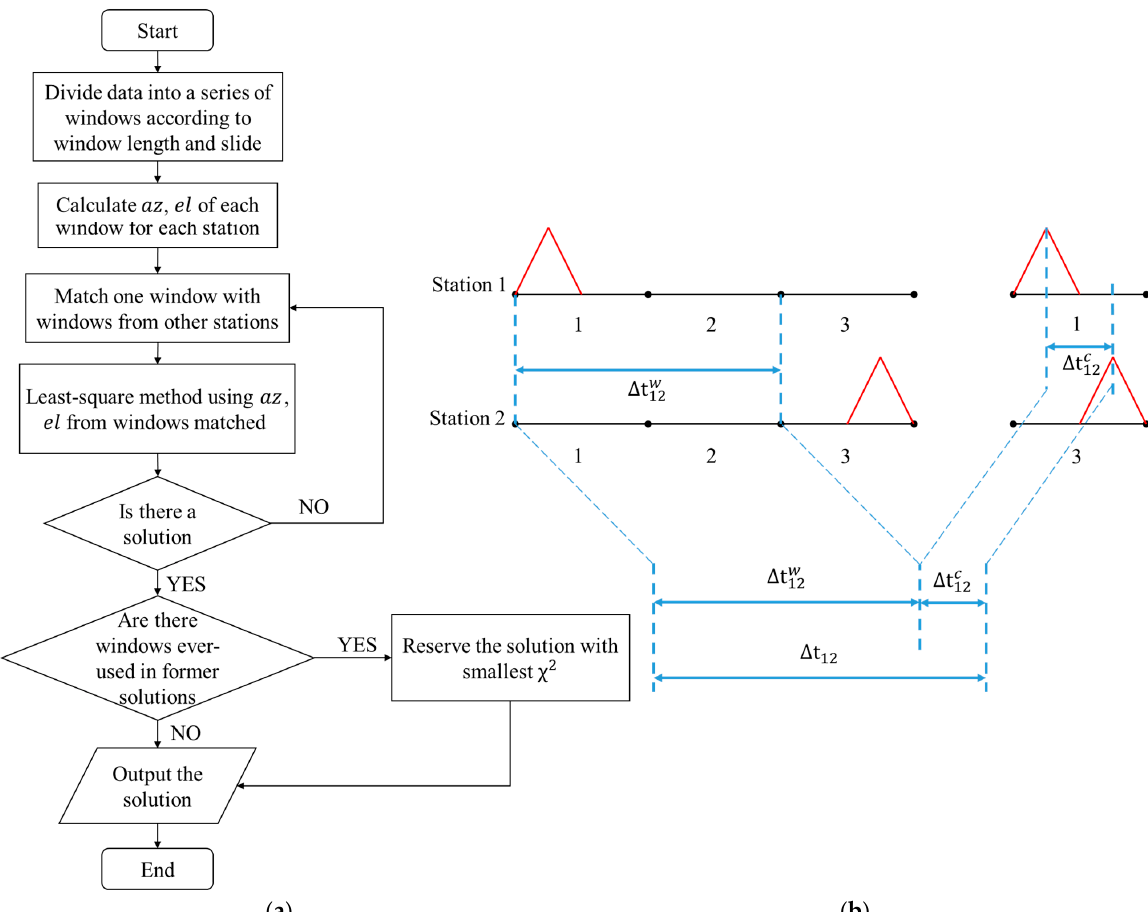
Figure 4. ( a ) Flow chart used in 3D mapping program; ( b ) Description of the method for finding the time arrival di ff erences windows between two stations.